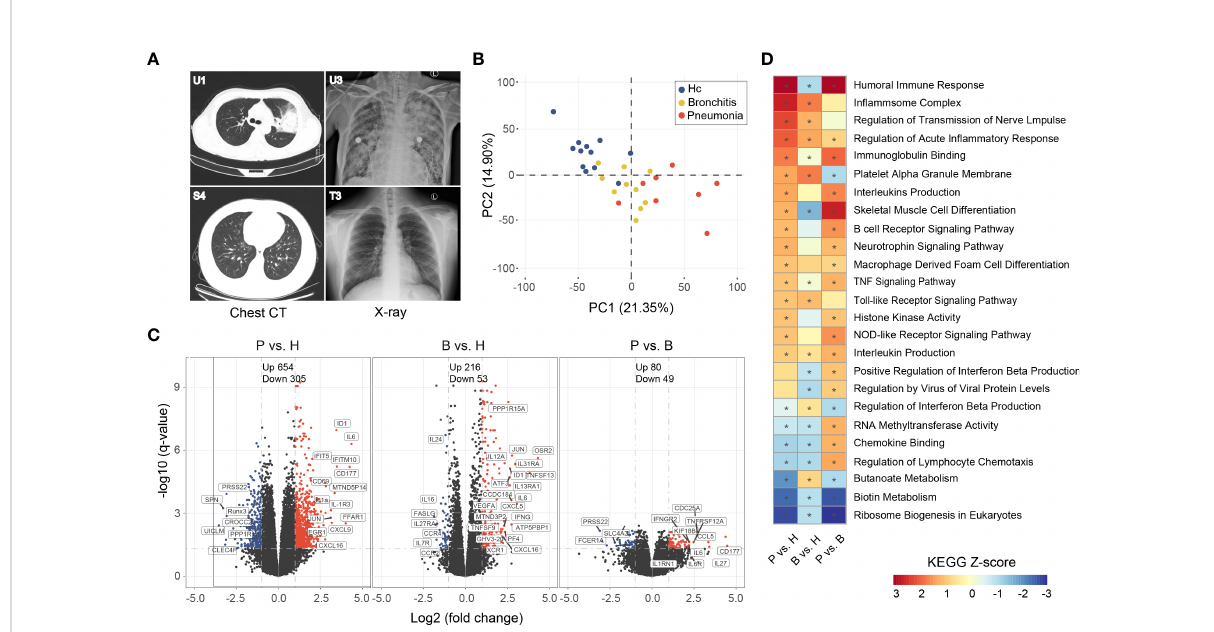
FIGURE 2 Imaging features of representative C. psittaci cases with pneumonia and gene expression analysis in PBMC of the C. psittaci cases compared to healthy controls. (A) Chest CTs obtained from U1 and S4, and X-ray obtained from U3 and T3. (B) PCA loading plot based on all DEGs. Autoscaling of the data was performed. (C) Volcano plot of DEGs comparing the pneumonia cases versus healthy (P vs. H), the bronchitis cases versus healthy (B vs. H), and the pneumonia cases versus the bronchitis cases (P vs. B). The names of DEGs related to immune response are shown. (D) Functional enrichment analysis of DEGs with the ingenuity pathway analysis. Asterisks (*) indicate p -values <0.05 and absolute Z - score ≥